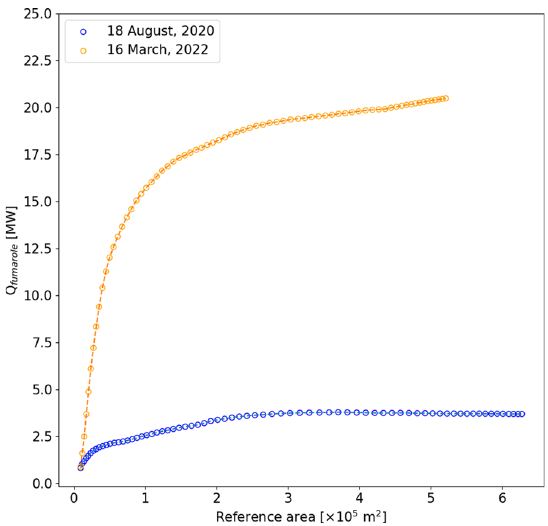
Fig. 7 Relation between the reference area and heat discharge rate. The heat discharge rate converges as the reference area increases